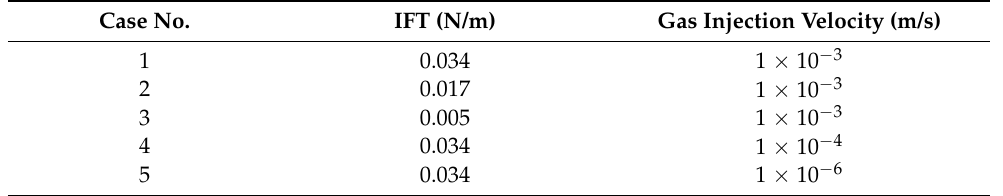
Table 2. Summary of cases studied.